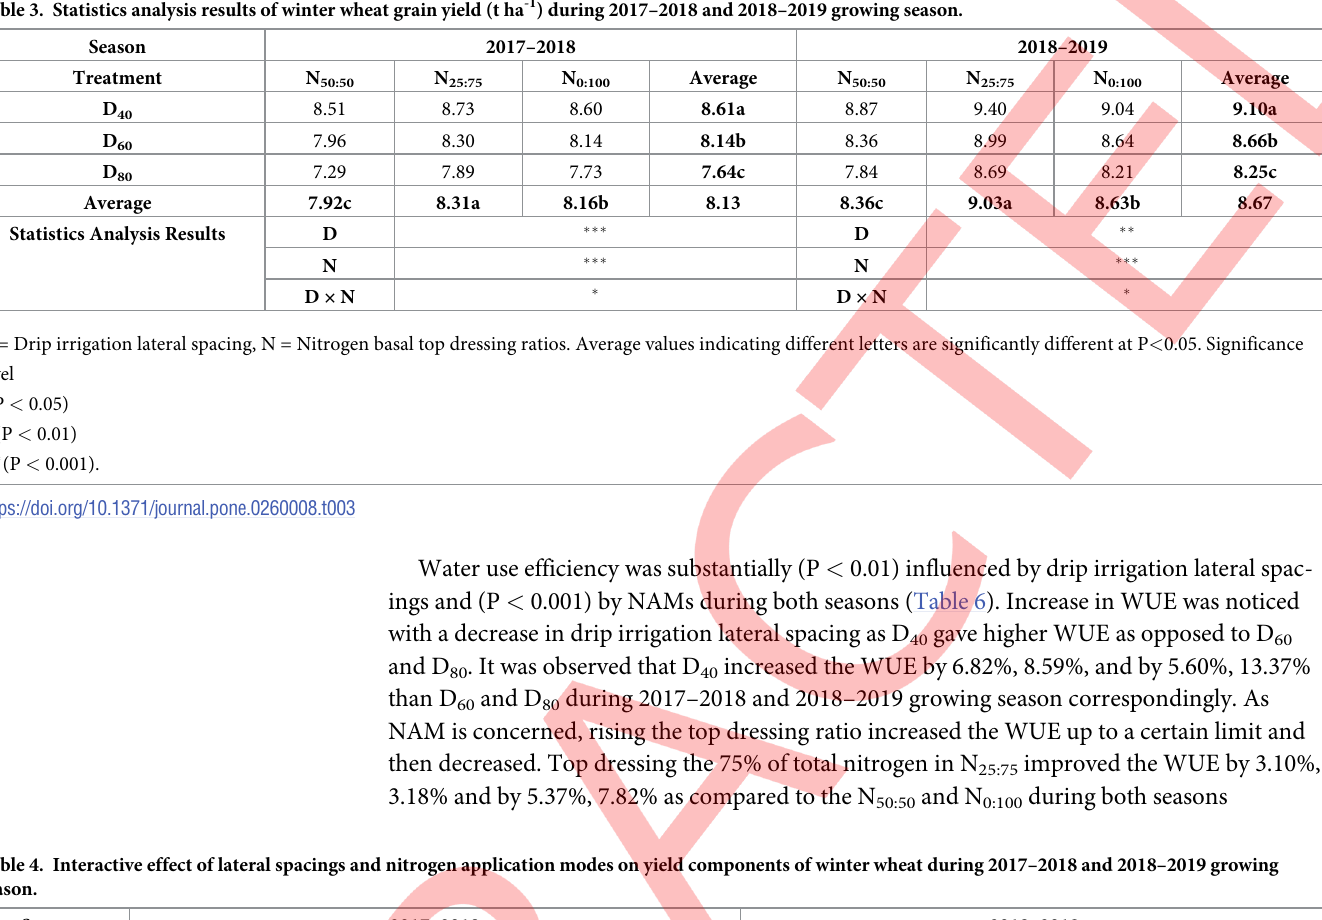
Table 3. Statistics analysis results of winter wheat grain yield (t ha -1 ) during 2017–2018 and 2018–2019 growing season. Season Treatment